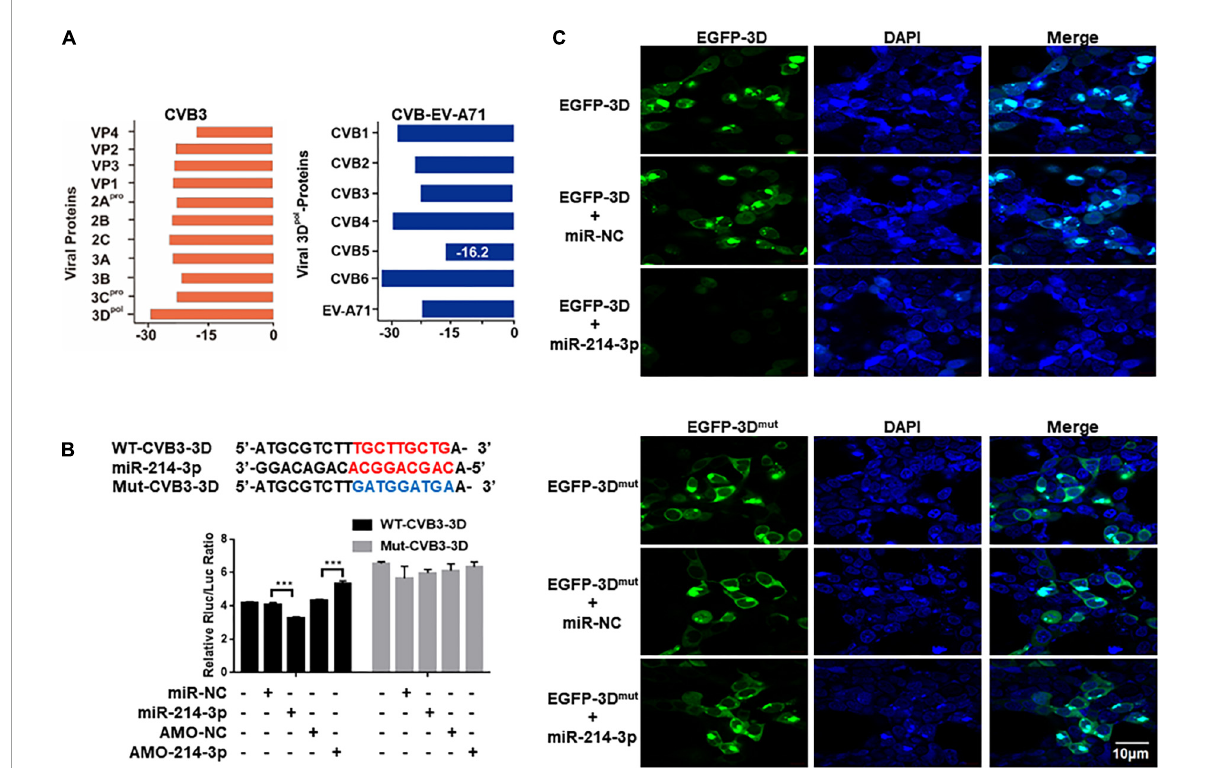
FIGURE5 Prediction and verification of miR-214-3p tergetig CVB3 genomic RNA. (A) Identification of the potential miR-214-3p-binding sites in CVB3 genomic RNA by RNAhybrid. The binding ability of miR-214-3p with CVB1- CVB6 3D and EV-A71 3D sequence. (B) The miR-214-3p-binding sequence in the CVB3 3D-coding sequence and the mutated CVB3 3D sequence. Wide-type CVB3 3D sequence (containing miR-214-3p-binding sequence, WT-CVB3-3D) or mutated CVB3 3D sequence (without miR-214-3p-binding sequence, Mut-CVB3-3D) was cloned into a luciferase-expressing plasmid. The plasmid was co-transfected separately with miR-214-3p, miR-NC, AMO-214-3p, or AMO-NC into HEK293T cells, respectively. The luciferase activity was detected with dual luciferase assay. The acitivity of Rluc was normalized with Luc. n = 3. *** P < 0.001. (C) HEK293T cells were co-transfected with pEGFP-CVB3-3D (EGFP-3D) or pEGFP-CVB3-3D mut (EGFP-3D mut ) and miR-214-3p for 24 h. Immunofluorescence staining was performed to detect the expression level of the CVB3 3D